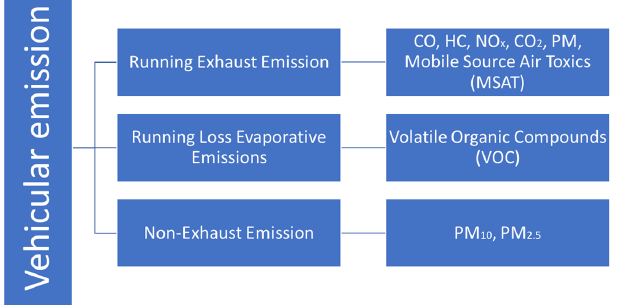
Figure 1. Types of vehicular emissions [2–4].